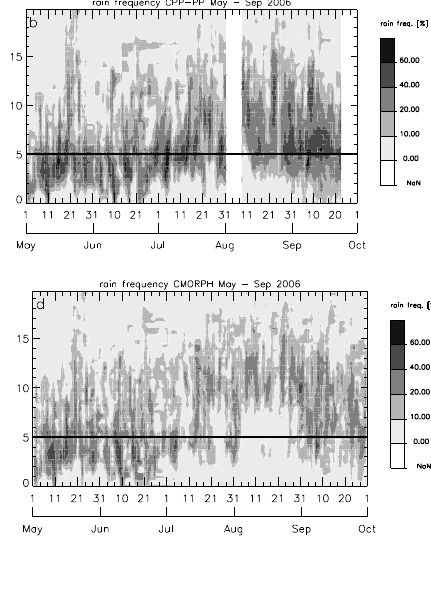
Fig. 8. As Figure 6, but for rain ocurrence frequency.